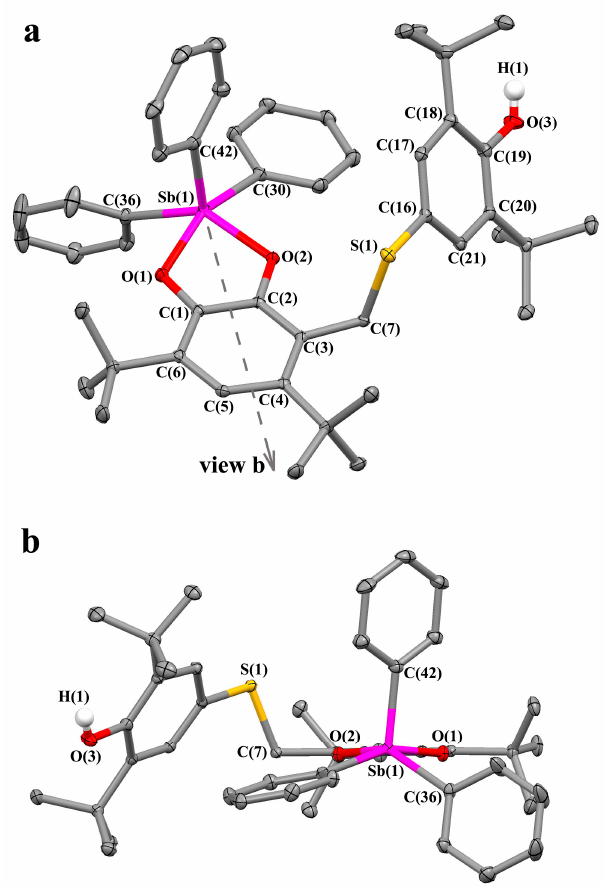
Figure 2. The X-ray structure of 1 : ( a ) the general view on molecule of 1 ; ( b ) the view on molecule 1 along the dotted line (view b) depicted on Figure 2a. The hydrogen atoms except hydroxyl hydrogen H(1) are omitted for clarity. The ellipsoids of 50% probability. The selected bond distances (Å): Sb(1)-